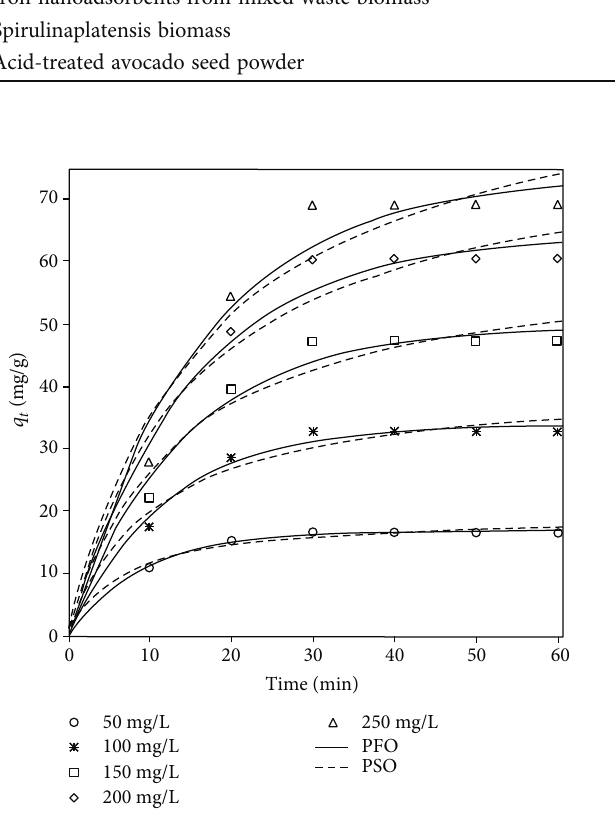
Figure 14: Kinetic study for the elimination of ARS dye by CTASP adsorbent.